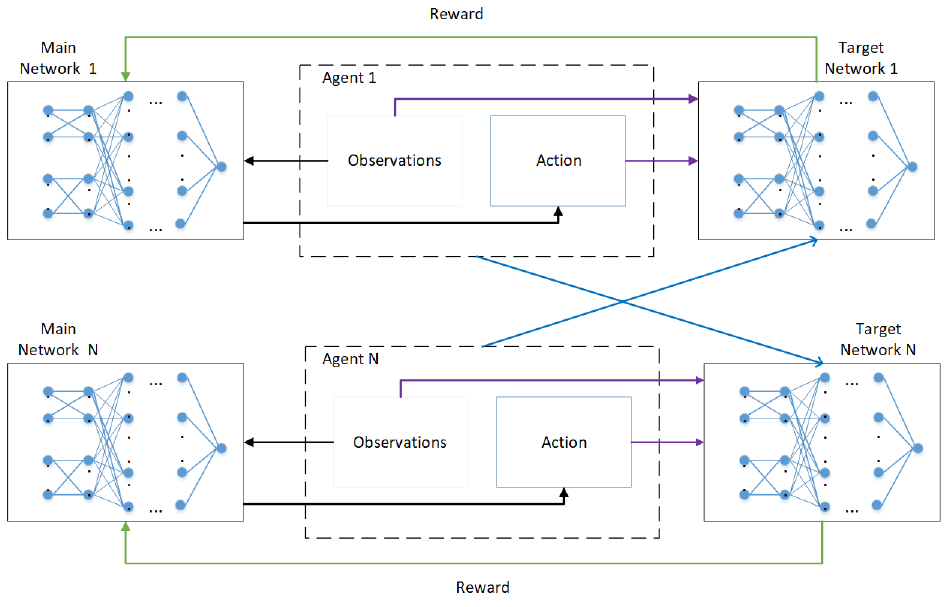
Figure 5. Architecture of the coordinating MADRL